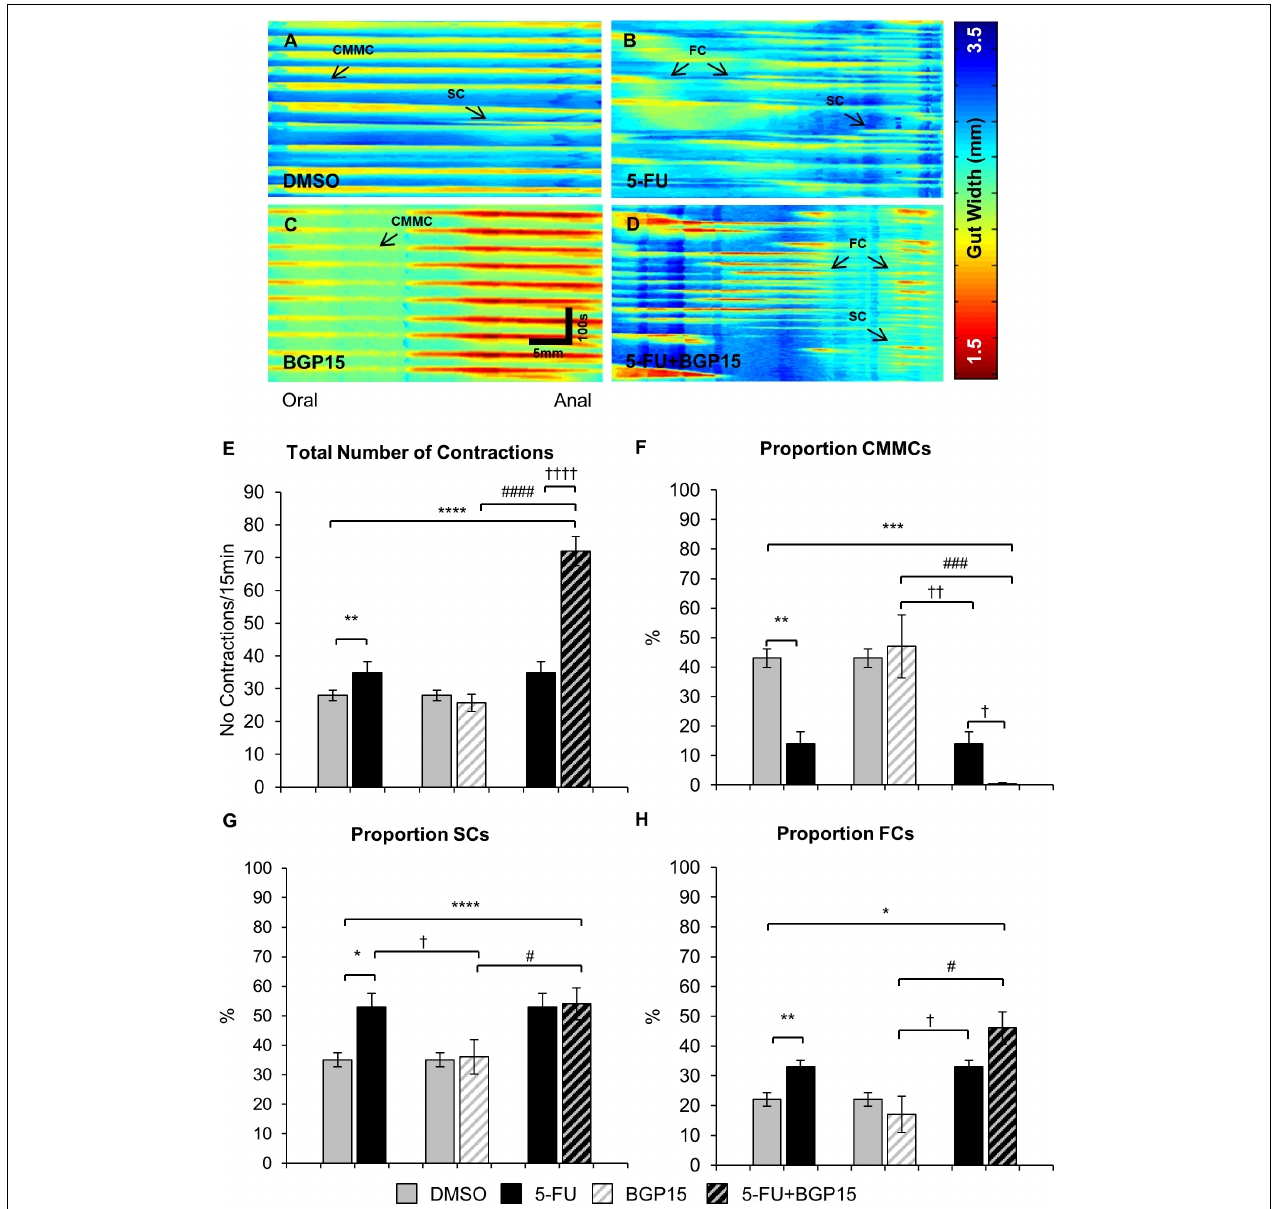
FIGURE 4 | Colonic motility following repeated in vivo 5-FU ± BGP-15 administration. Representative spatiotemporal maps generated from digital video recordings of colonic motility following 14 days of DMSO (A) , 5-FU (B) , BGP-15 (C) , and 5-FU+BGP-15 (D) administration. Each contraction can be seen as a reduction in the gut width (red), while relaxation as an increase in the gut width (blue). Colonic migrating motor complexes (CMMCs) propagate > 50% of the colon length, short contractions (SCs) propagate < 50% of the colon length and fragmented contractions (FCs) are interrupted by period(s) of relaxation during contraction. Total number of contractions including all types of contractile activity in the colons from DMSO, 5-FU, BGP-15, and 5-FU+BGP-15 administration (E) . The proportion of CMMCs to the total number of contractions (F) . The proportion of SCs to the total number of contractions (G) . The proportion of FCs to the total number of contractions (H) . Data represented as mean ± SEM. ∗ P < 0.05, ∗∗ P < 0.01, ∗∗∗ P < 0.001, ∗∗∗∗ P < 0.0001, significantly different to DMSO group. † P < 0.05, †† P < 0.01, †††† P < 0.0001, significantly different to 5-FU group. # P < 0.05, ### P < 0.001, #### P < 0.0001, significantly different to BGP-15 ( n = 5